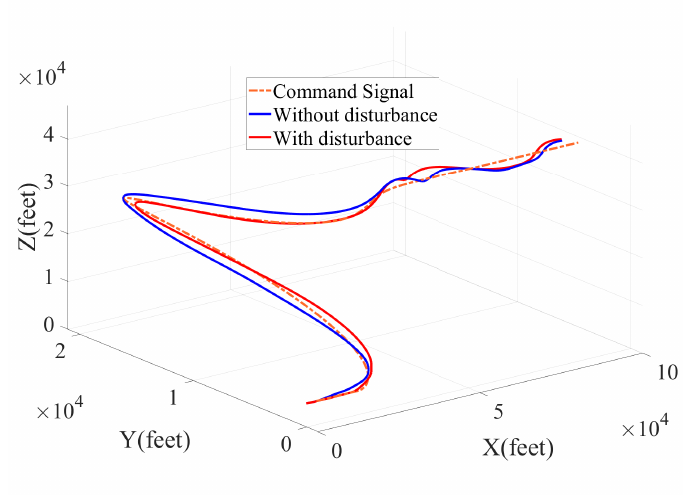
Figure 5. Trajectory in 3-dimensional